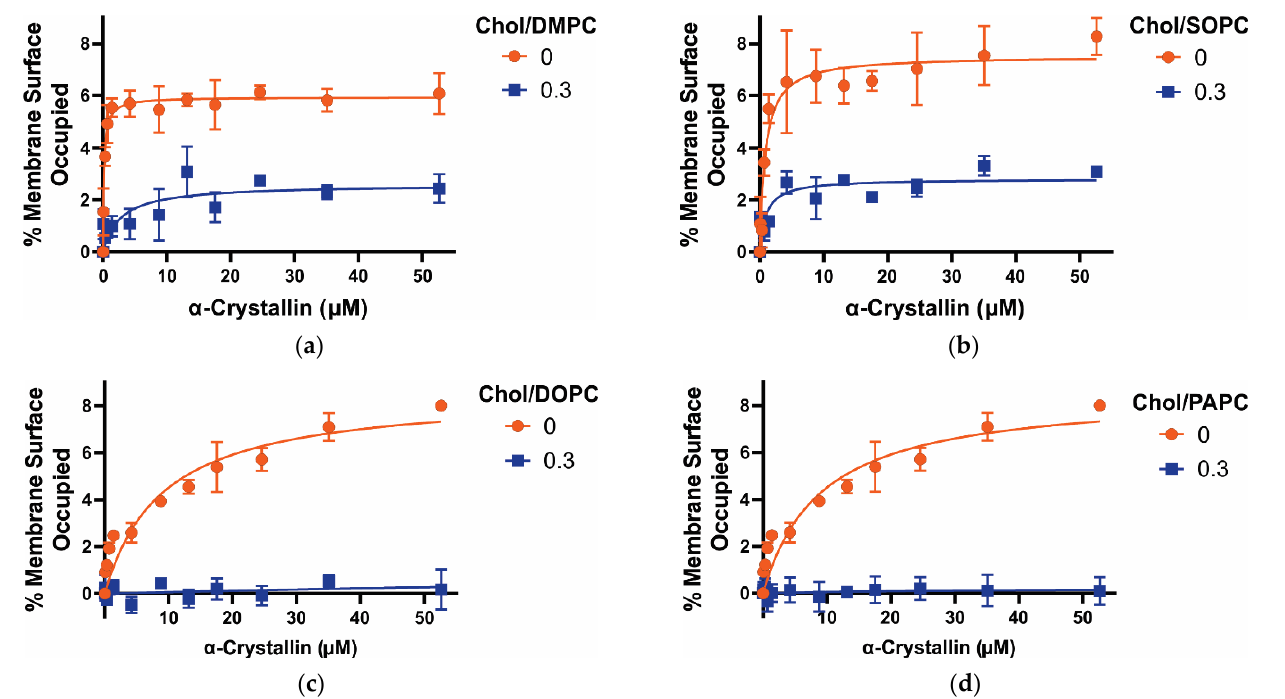
Figure 2. ( a – d ) Show the percentage of membrane surface occupied (MSO) plotted as a function of α -crystallin concentration for Chol/DMPC, Chol/SOPC, Chol/DOPC, and Chol/PAPC membranes, respectively, at Chol and PL mixing ratios of 0 and 0.3. A fixed concentration of PL plus Chol (11.4 mM) in the membrane and varied concentration of α -crystallin (0–52.6 µM) was mixed and incubated at 37 °C for 16 h and EPR measurements were taken at 37 °C. The detailed method to calculate the MSO is explained in our previous studies [45–47]. The data points are expressed as mean ± standard deviation from three independent experiments and fitted using a one-site ligand binding model (see Equation (2) in [46,47]) in GraphPad Prism (San Diego, CA, USA) to calculate the association constant (K a ). The rate of increase of MSO with respect to α -crystallin concentration is different for different PC membranes, showing that acyl chain length and degree of unsaturation of PC membranes modulate the α -crystallin-membrane association. Independent of the PC lipid type, Chol decreases the MSO, representing that Chol inhibits the α -crystallin-membrane association. With Chol/PC mixing ratio of 0.3 (Figure 2), the MSO by α -crystallin sharply de- creases close to zero for polyunsaturated membranes (i.e., Chol/DOPC and Chol/PAPC); however, it decreases ~60% for saturated (i.e., DMPC) and monounsaturated (i.e., SOPC) membranes. MMSO values, when compared with and without Chol, show a statistically significant difference with p ≤ 0.05 for all PC membranes. These results suggest that Chol decreases the MSO by α -crystallin; however, the decrease level depends on the acyl chain length and degree of unsaturation. We have recently found a similar decrease in MSO by α -crystallin in the presence of Chol for membranes with different headgroups but the same acyl chain length and degree of unsaturation; however, the level of decrease de- pends upon the lipid headgroup type [47]. Previously, Tang et al. [35] investigated the association of α -crystallin with Chol/distearoyl-phosphatidylcholine (DSPC), Chol/SM, and Chol/egg PC membranes using a fluorescence approach and found that Chol de- creases the α -crystallin association with DSPC and SM membranes but increases the α - crystallin association with egg PC membrane. In contrast, Cobb and Petrash [28] used AlexaFluor350TM-conjugated α -crystallin and found no significant association of α -crys- tallin with and without Chol in PC and SM membranes. The surface hydrophobicity of DMPC, SOPC, DOPC, and PAPC membranes decreases with an addition of Chol (see Sec- tion 3.5) irrespective of the acyl chain length and degree of unsaturation. The decrease in surface hydrophobicity with the corresponding decrease in MSO with the addition of Chol suggests that the α -crystallin interacts with the membrane via hydrophobic interac- tion. 3.2. K a of α -Crystallin Association with Saturated, Monounsaturated, and Polyunsaturated Membranes To compute the K a , the MSO versus α -crystallin concentration data shown in Figure 2 were fitted using a one-site ligand binding model (see equation 2 in [46,47]) in GraphPad Prism (San Diego, CA, USA). The K a gives the strength of α -crystallin-membrane associa- tion. The higher the K a , the stronger the α -crystallin-membrane association. If α -crystallin does not associate with the membrane, the MSO and K a values are both 0. The value of K a is determined by how quickly the MSO increases if α -crystallin is associated with the membrane. In other words, K a provides a quantitative estimate of how quickly the MMSO